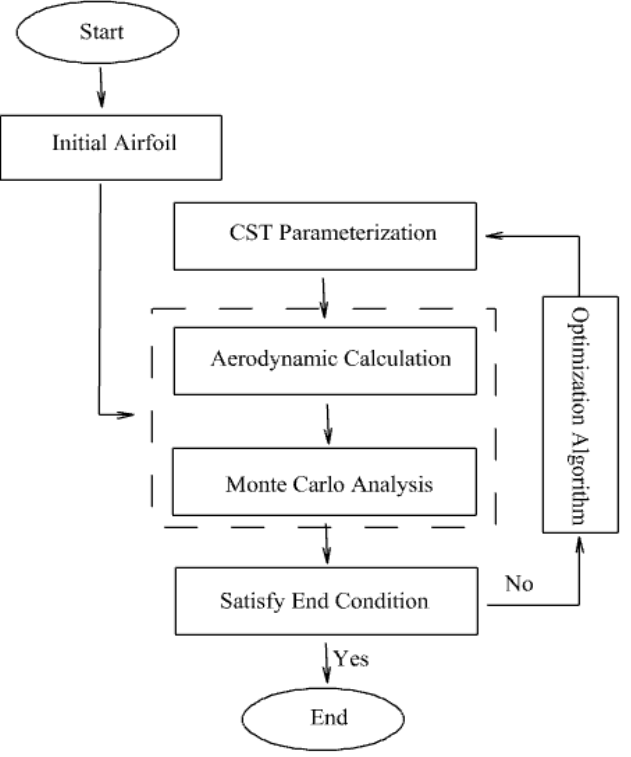
Figure 2. Flow chart of robust optimization.